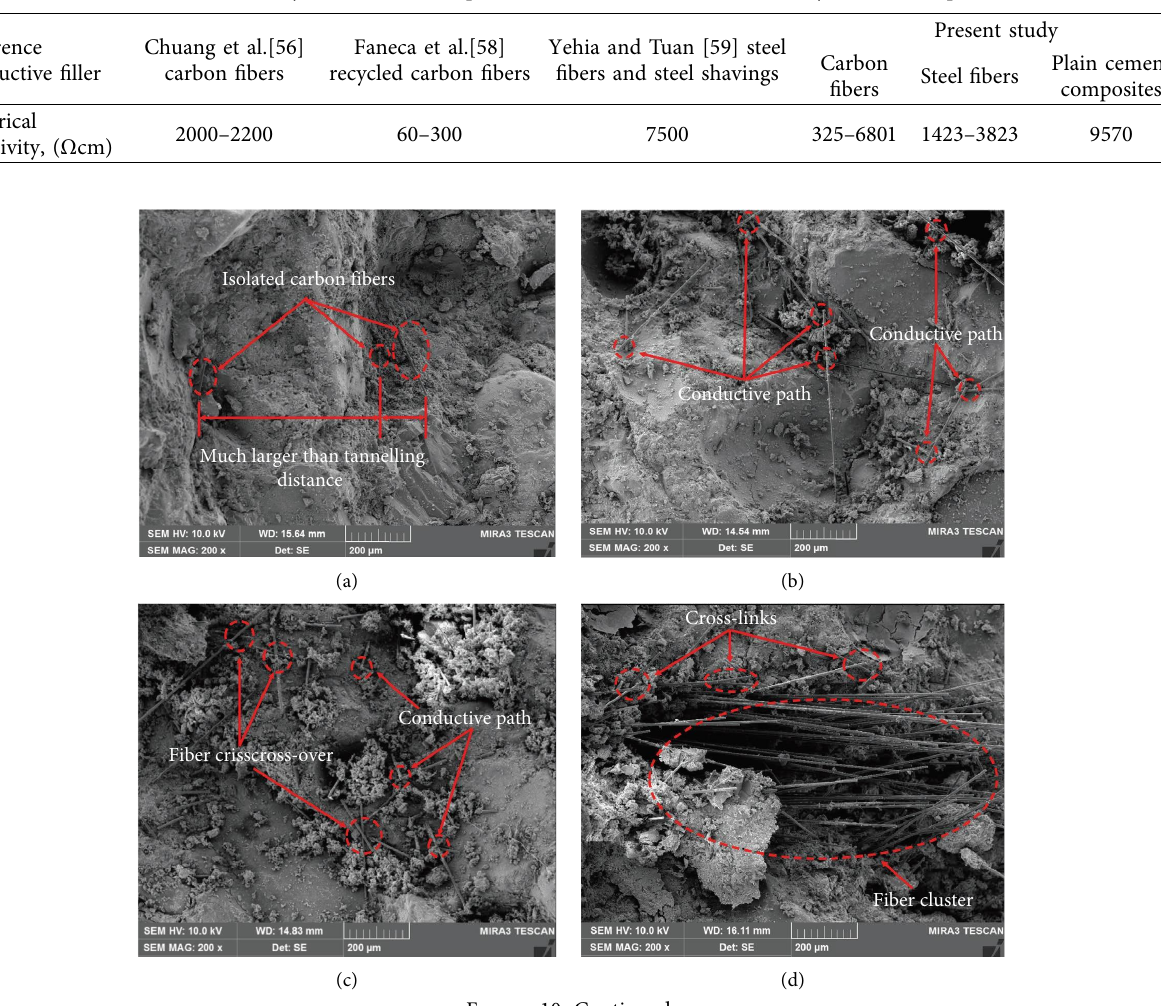
Figure 9: Variation of electrical resistivity by fber dosage in SFRCC and CFRCC. (a) Fiber volume fraction SF (%) and (b) fber volume fraction CF (%). Table 6: Summary of test results in previous studies on electrical resistivity cement